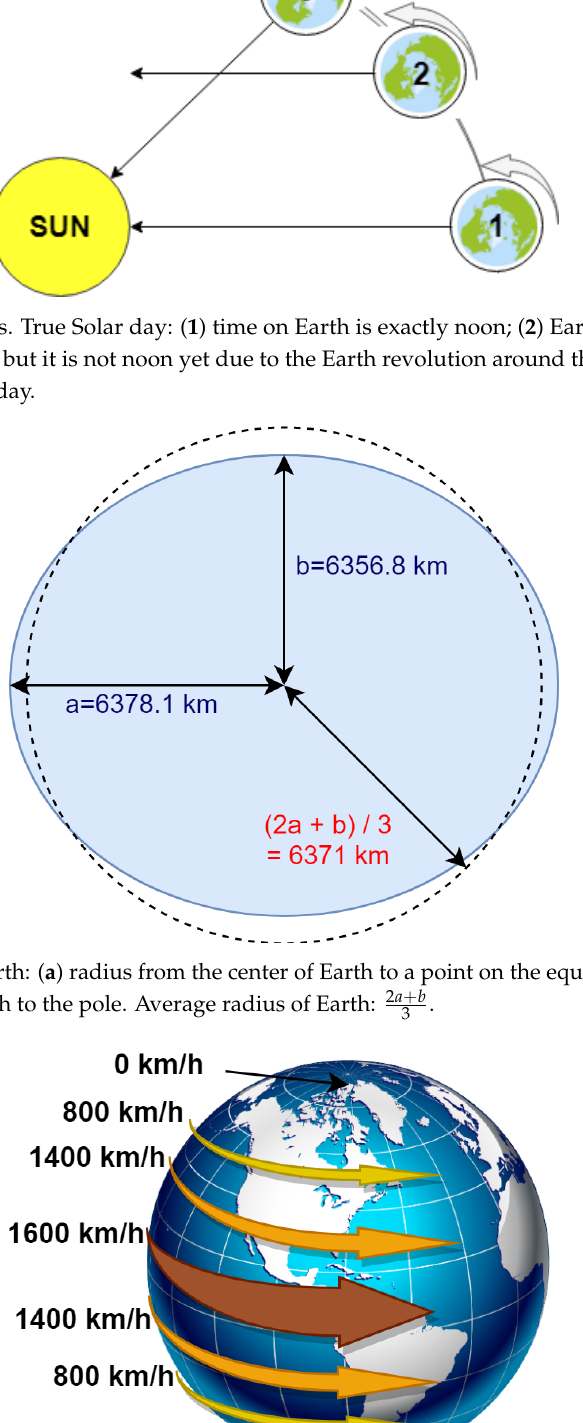
Figure 3. Rotational speed of Earth differs according to the latitude line. In Canada, it equals 800 km/h, while it doubles in Colombia to be 1600